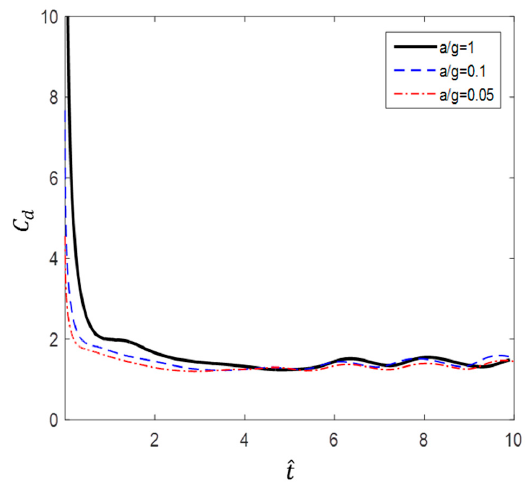
Figure 22. Dimensionless time variation of drag coe ffi cient C d ∗ ( Re 0 = 1000).